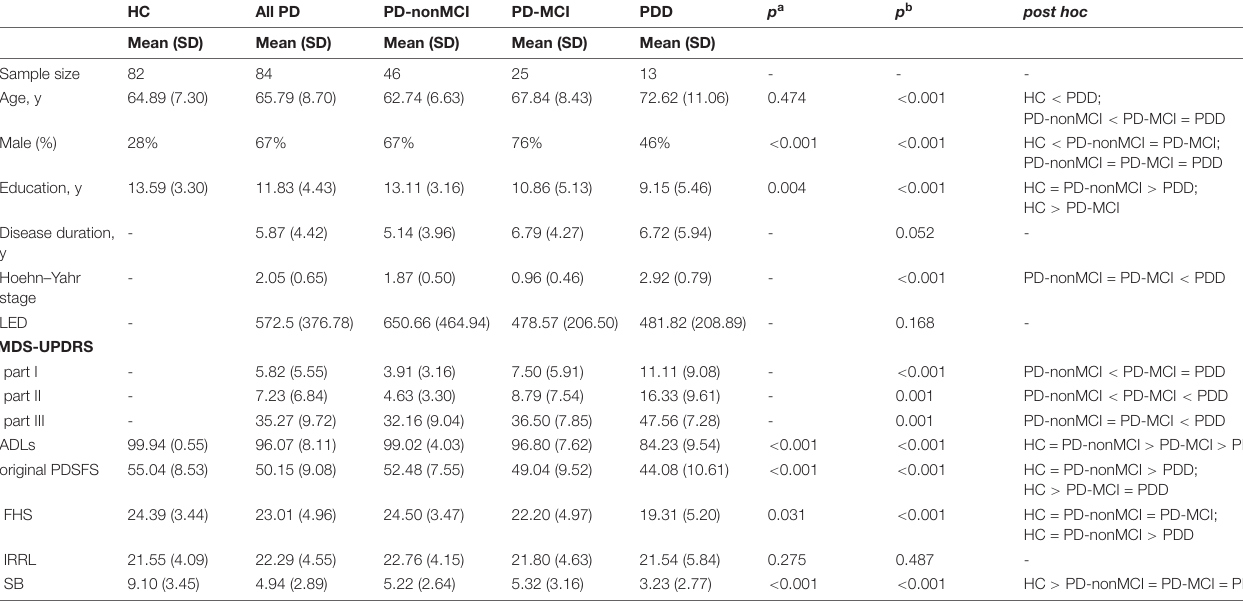
TABLE 4 | Demographics and clinical characteristics in study